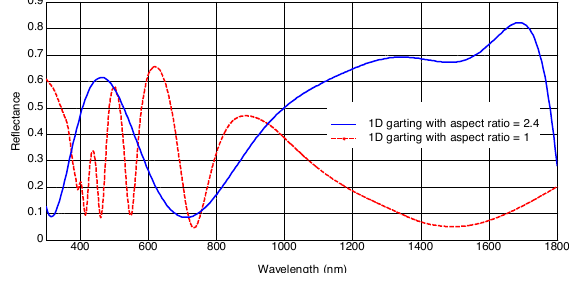
Figure 18. 1D grating structure with aspect ratio of 1 (red curve) and 2.4 (blue